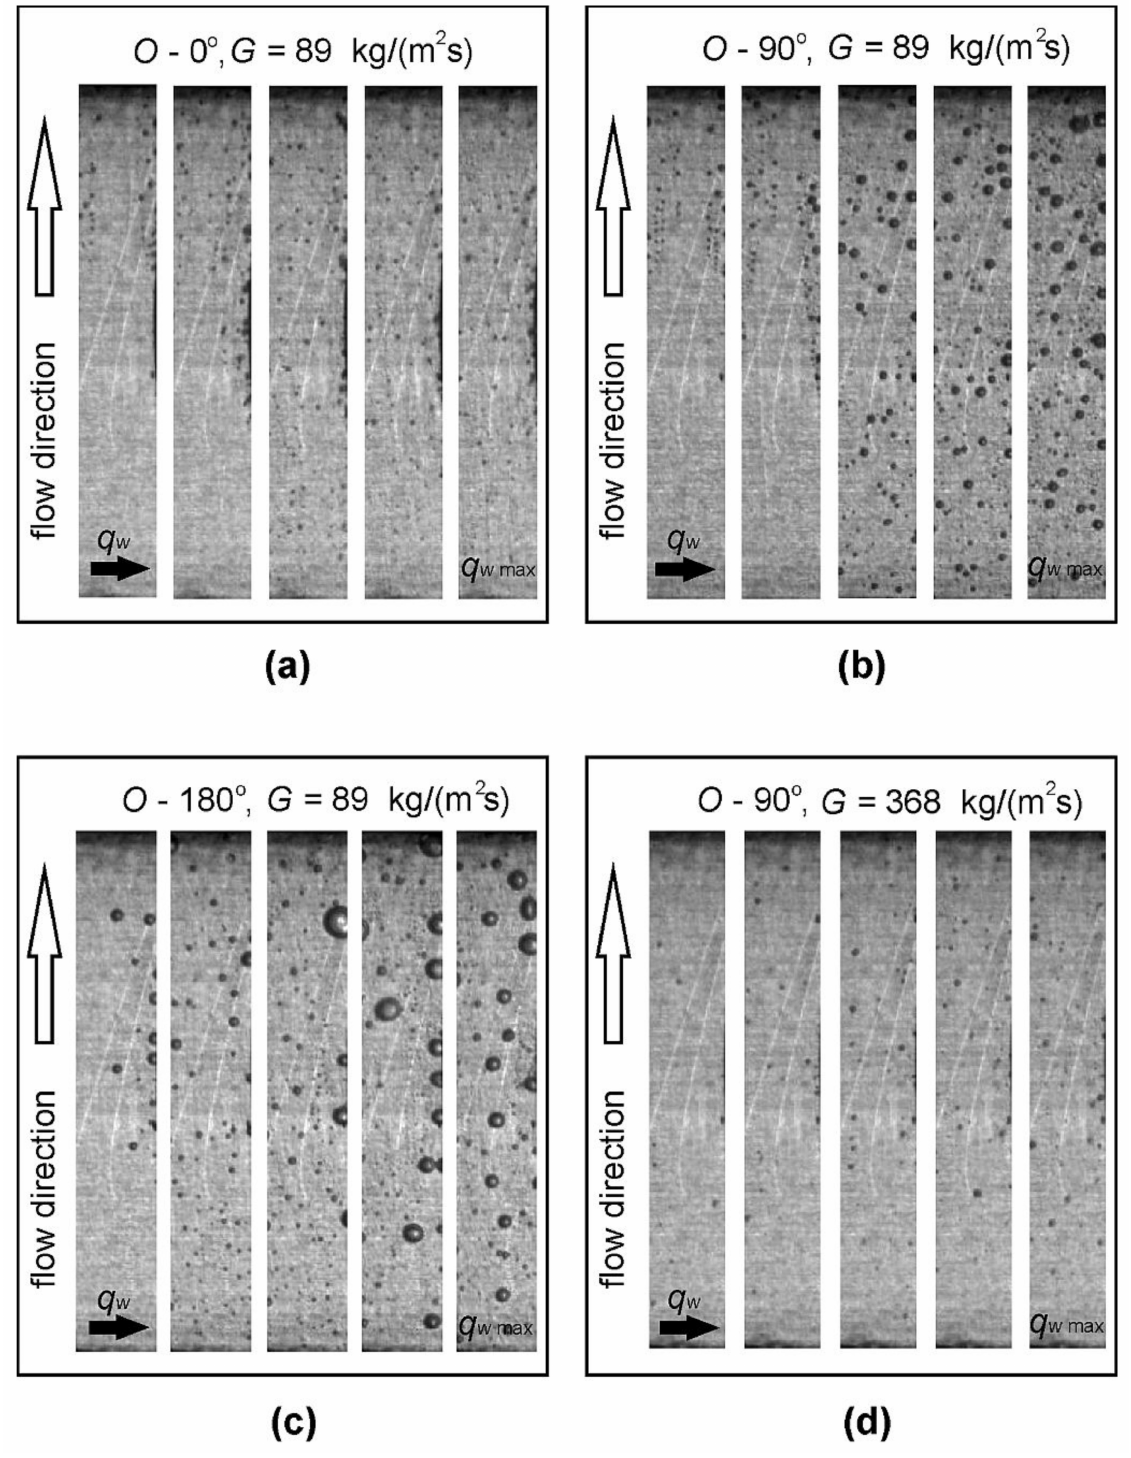
Figure 13. Images of two-phase flow structures recorded for: various mass fluxes and three channel orientations (0 ◦ , 90 ◦ and 180 ◦ ), FC-72, smooth heated plate, L IRT = 32